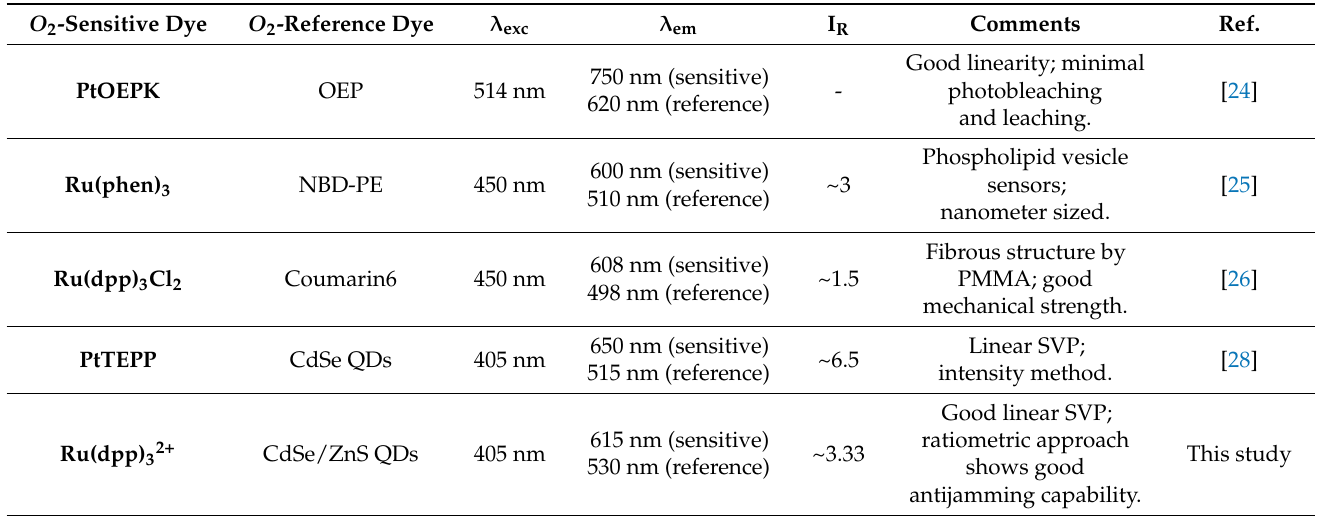
Table 1. Comparison of different ratiometric dissolved oxygen sensors. λ exc and λ em are spectral peaks of excitation and emission, respectively; SVP means Stern-Volmer plot; I R = I 0 /I 100 is the ratio of fluorescence intensity at 0% O 2 and 100% O 2